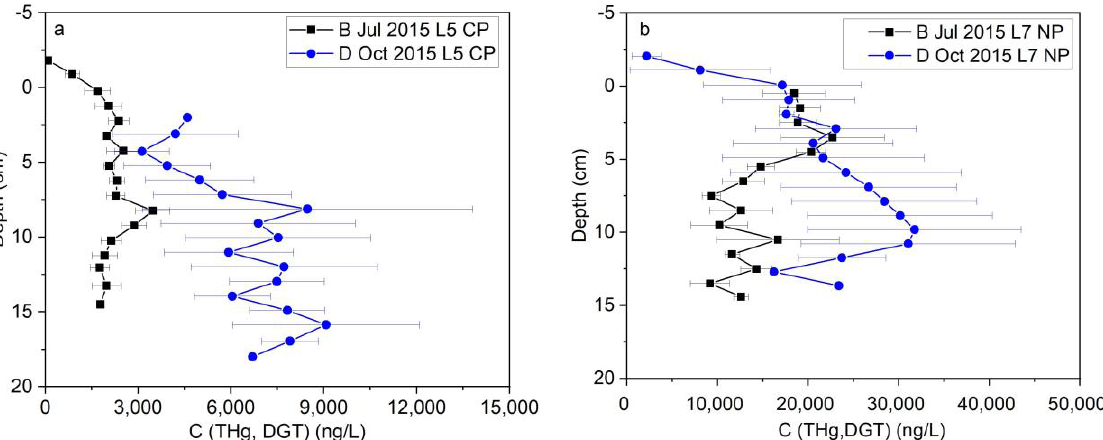
Figure 5. ( a ) Porewater THg concentration measured with DGT at L5 (Constitution Park) during Baseline (B) (July 2015) and Drainage (D) (October 2015); ( b ) porewater THg concentration measured with DGT at L7 (North Park) during Baseline (B) (July 2015) and Drainage (D) (October 2015); on the y-axis, 0 represents the water/sediment interface and the negative numbers refer to distances above the interface (i.e., in the water column).